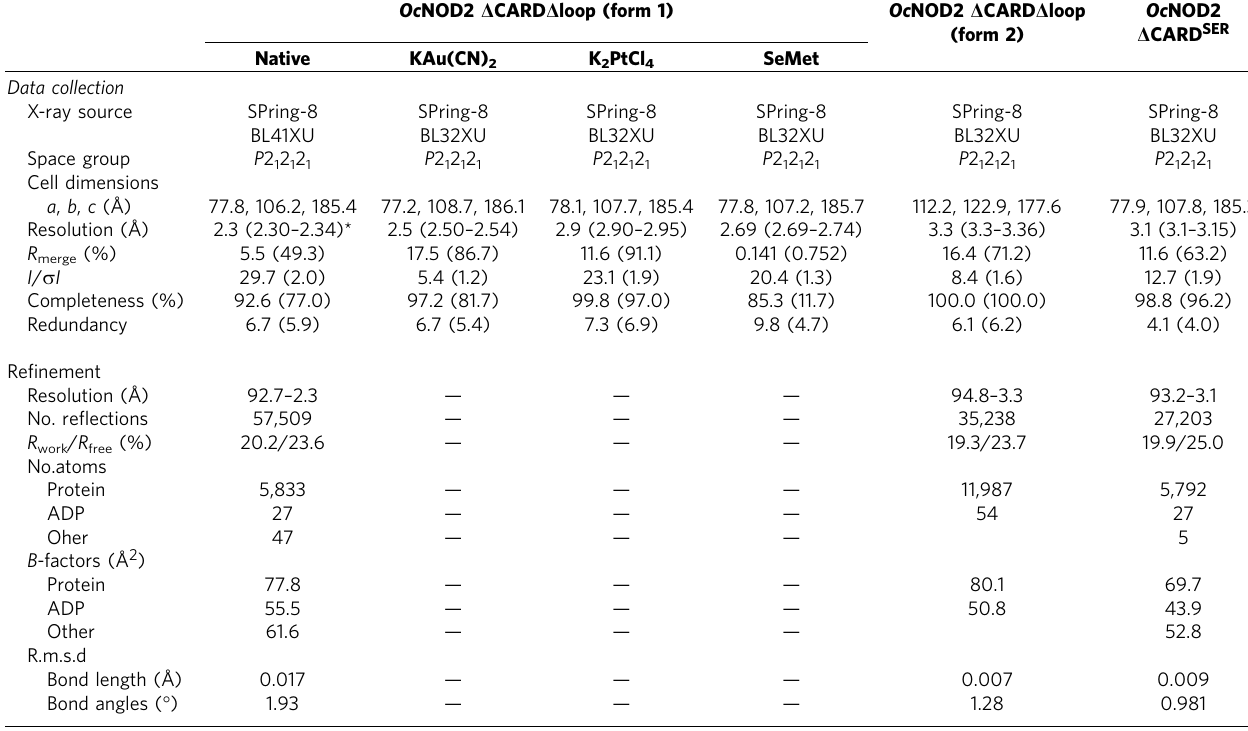
Table 1 | Data collection and refinement